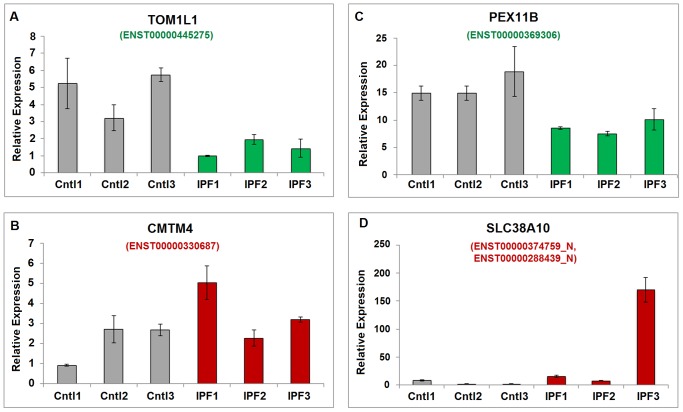
The qRT-PCR validation results for the annotated transcripts and the novel transcripts.(A) The validation result for the down-regulated (in green color) isoform ENST0000445275 of gene TOM1L1. (B) The validation result for the up-regulated (in red color) isoform ENST0000330687 of gene CMTM4. (C) The validation result for the down-regulated (in green color) isoform ENST0000369306 of gene PEX11B. (D) The validation result for the mixture of up-regulated (in red color) novel transcripts ENST00000374759_N and ENST00000288439_N of gene SLC38A10.